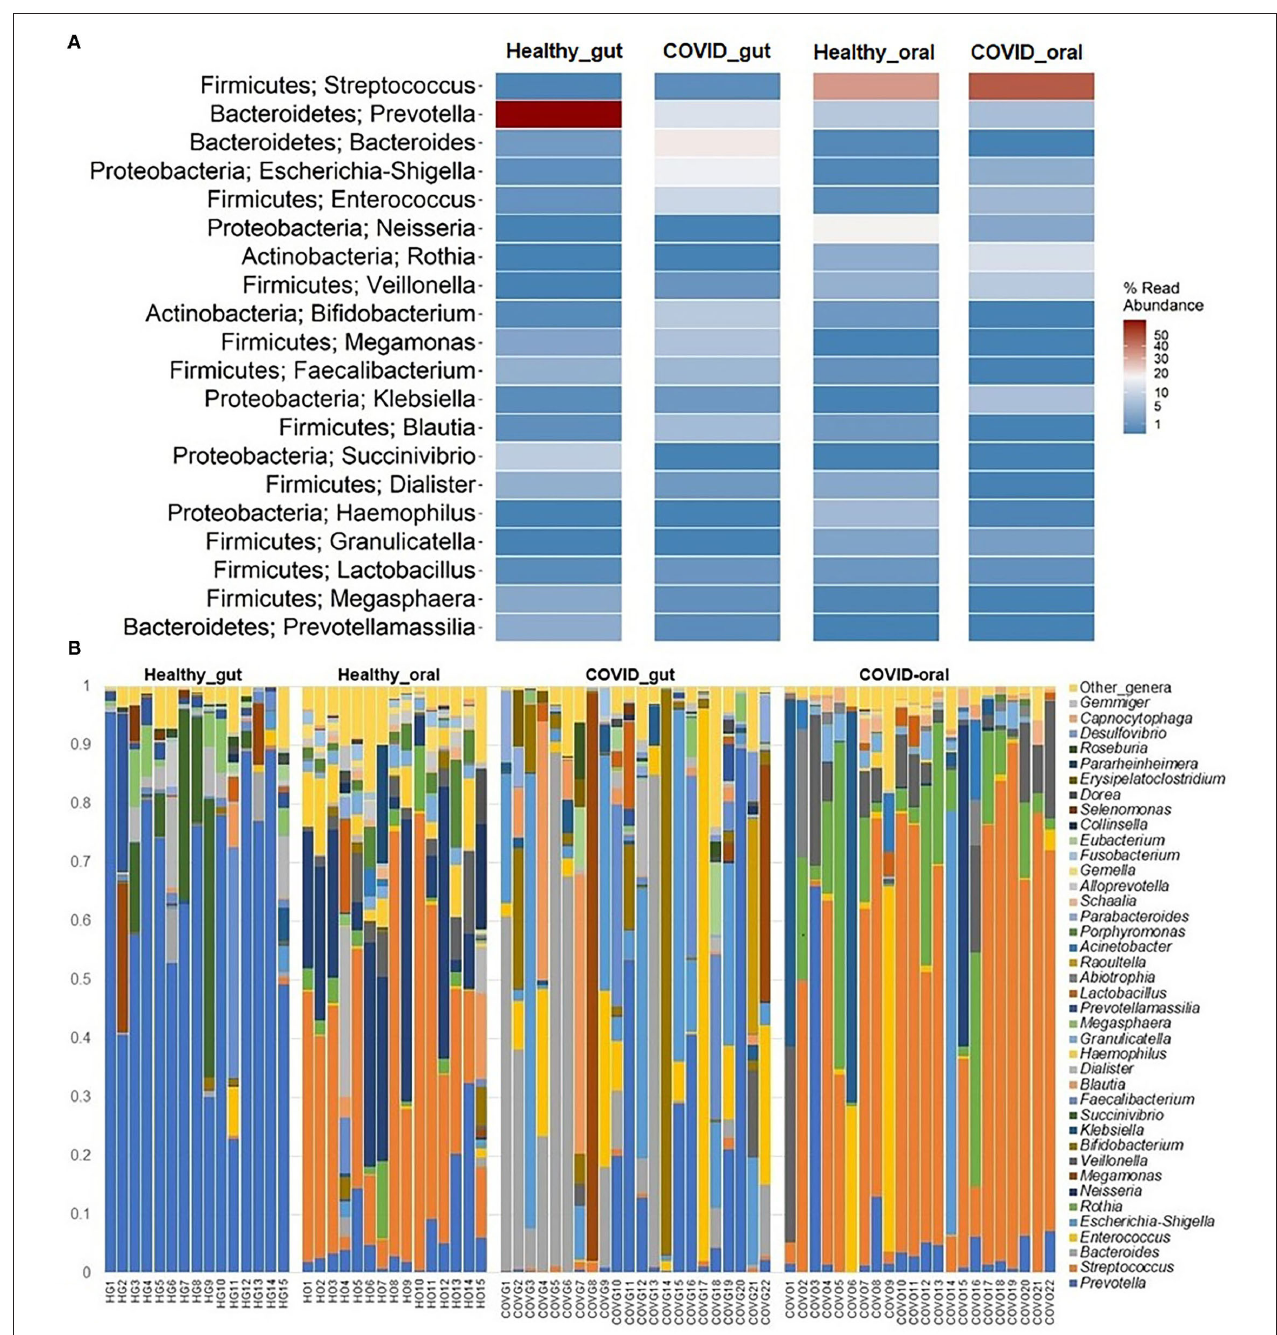
FIGURE 5 | The taxonomic abundance of bacteria in the gut and oral wash of healthy controls and COVID-19 cases. (A) Heatmap showing top 20 bacterial genera along with their corresponding phyla in the four sample groups. The color bar represents the abundance value (%) of each genus ranging from 1 (lowest abundance; expressed in dark blue color) to 100 (highest abundance; expressed in brick red color) in the corresponding sample group. (B) Relative abundance of 39 bacterial genera in the gut and oral samples of healthy control and patients with COVID-19. The abundance is sorted from bottom to top by the decreasing pattern of bacteria with the remaining genera kept as “other genera.” Each stacked bar represents the abundance of bacterial genera in each sample of the corresponding category.